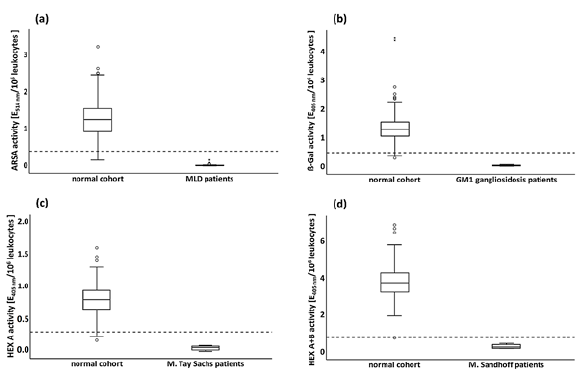
Figure 4. Boxplot of normal and pathological cohort for each analyzed lysosomal enzyme. Set minimal permissible values are indicated as dashed horizontal lines; : outliers. ( a ) Arylsulfatase A activity (ARSA) in normal ( n = 474) and pathological cohort ( n = 48); ( b ) β -galactosidase activity ( β -Gal) in normal ( n = 369) and pathological cohort ( n = 3); ( c ) β -hexosaminidase A activity (HEX A) in normal